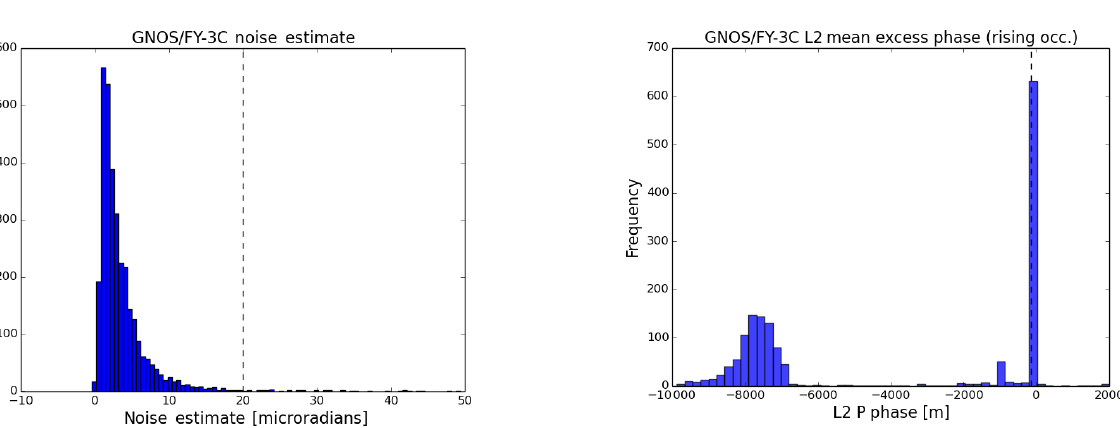
Figure 10. The histogram of the noise_estimate parameter using 7d of data from 16 to 22 February 2017.